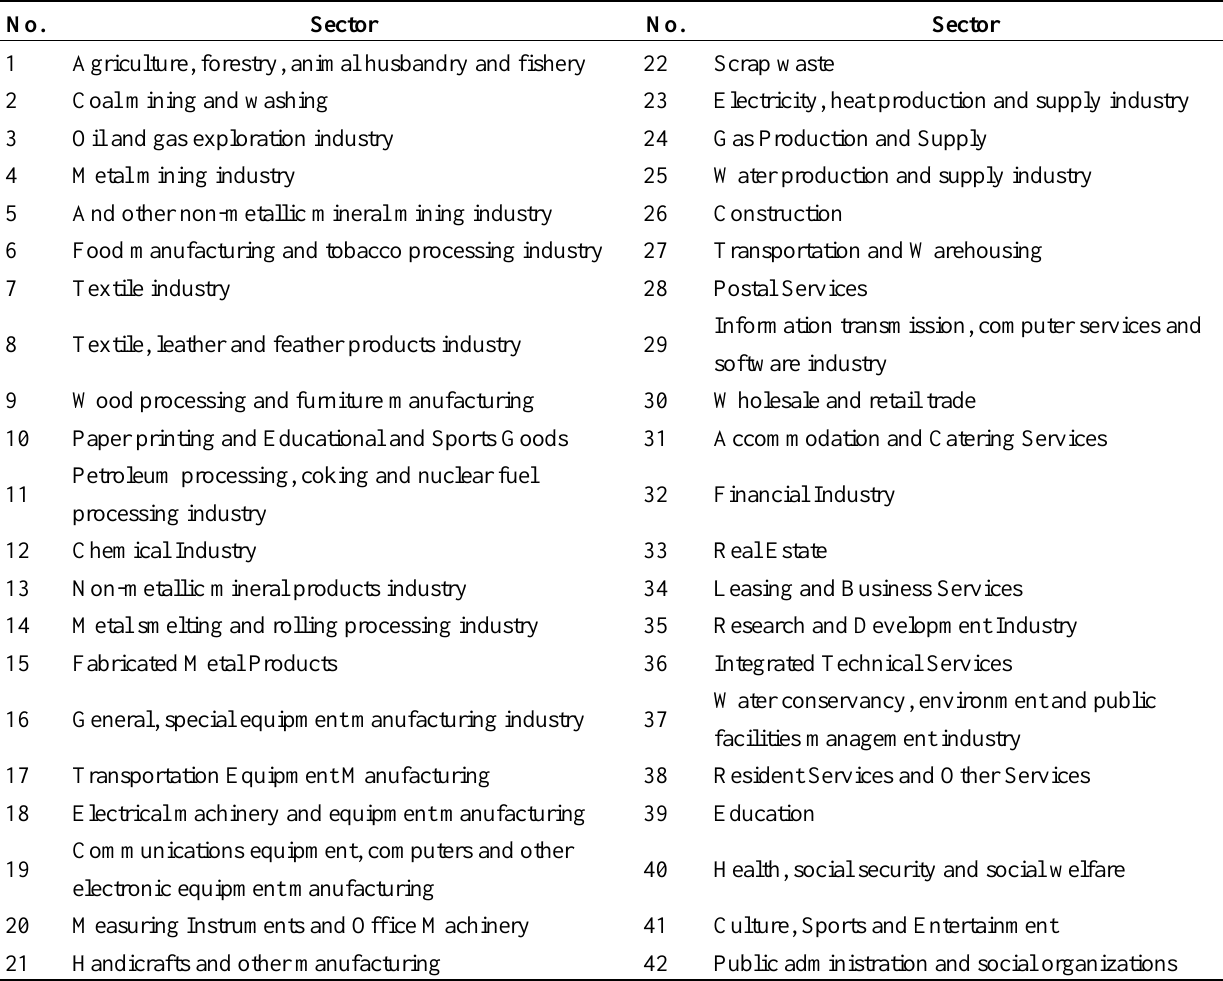
Table 1. Sector classification in CGE